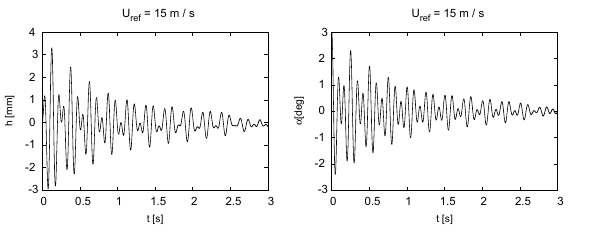
Fig. 15. Aeroelastic response for the seconde considered case in terms of h and α in time domain for far field velocity U ∞ = 26